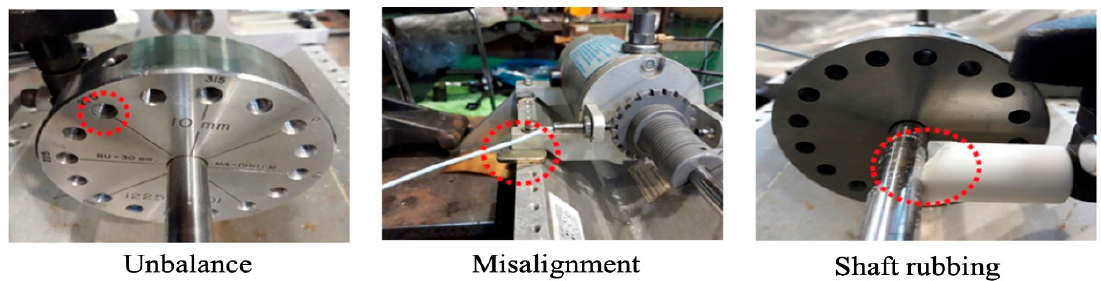
Figure 3. Measurement of the experiment system.